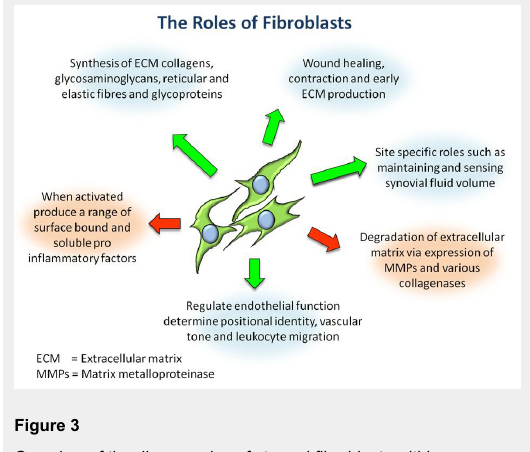
Overview of the diverse roles of stromal fibroblasts within connective